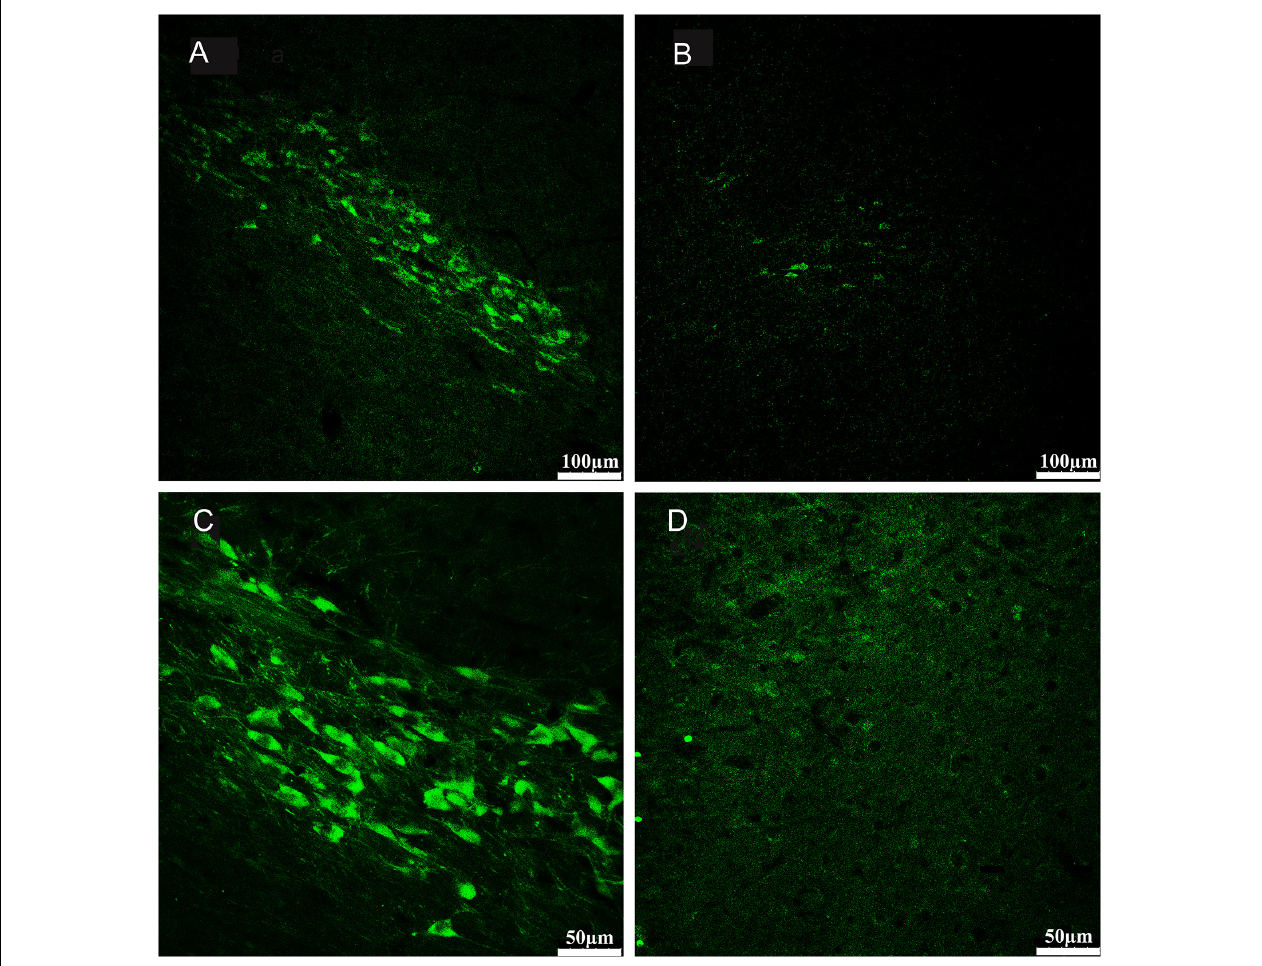
FIGURE 3 | Sections from substantia nigra pars compacta of example rat showed fluorescence immunohistochemical staining for tyrosine hydroxylase (TH). Compared with the no- 6-OHDA-treated hemisphere (A,C) , which contained an intact population of dopaminergic neurons positive for TH staining, the 6-OHDA-treated hemisphere (B,D) displayed a severe loss of TH-positive neurons in the substantia nigra pars compacta. The subpanels in bottom (C,D) provide magnified views on the subpanels in top (A,B) , respectively. ( A,B 100 × ; C,D 200 ×